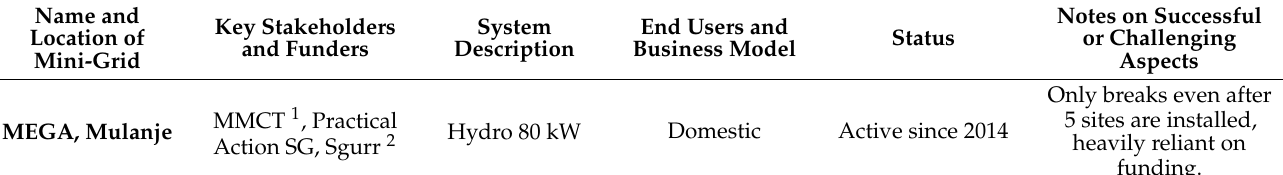
Table 9. Summary of past and present mini-grid initiatives in Malawi (adapted from